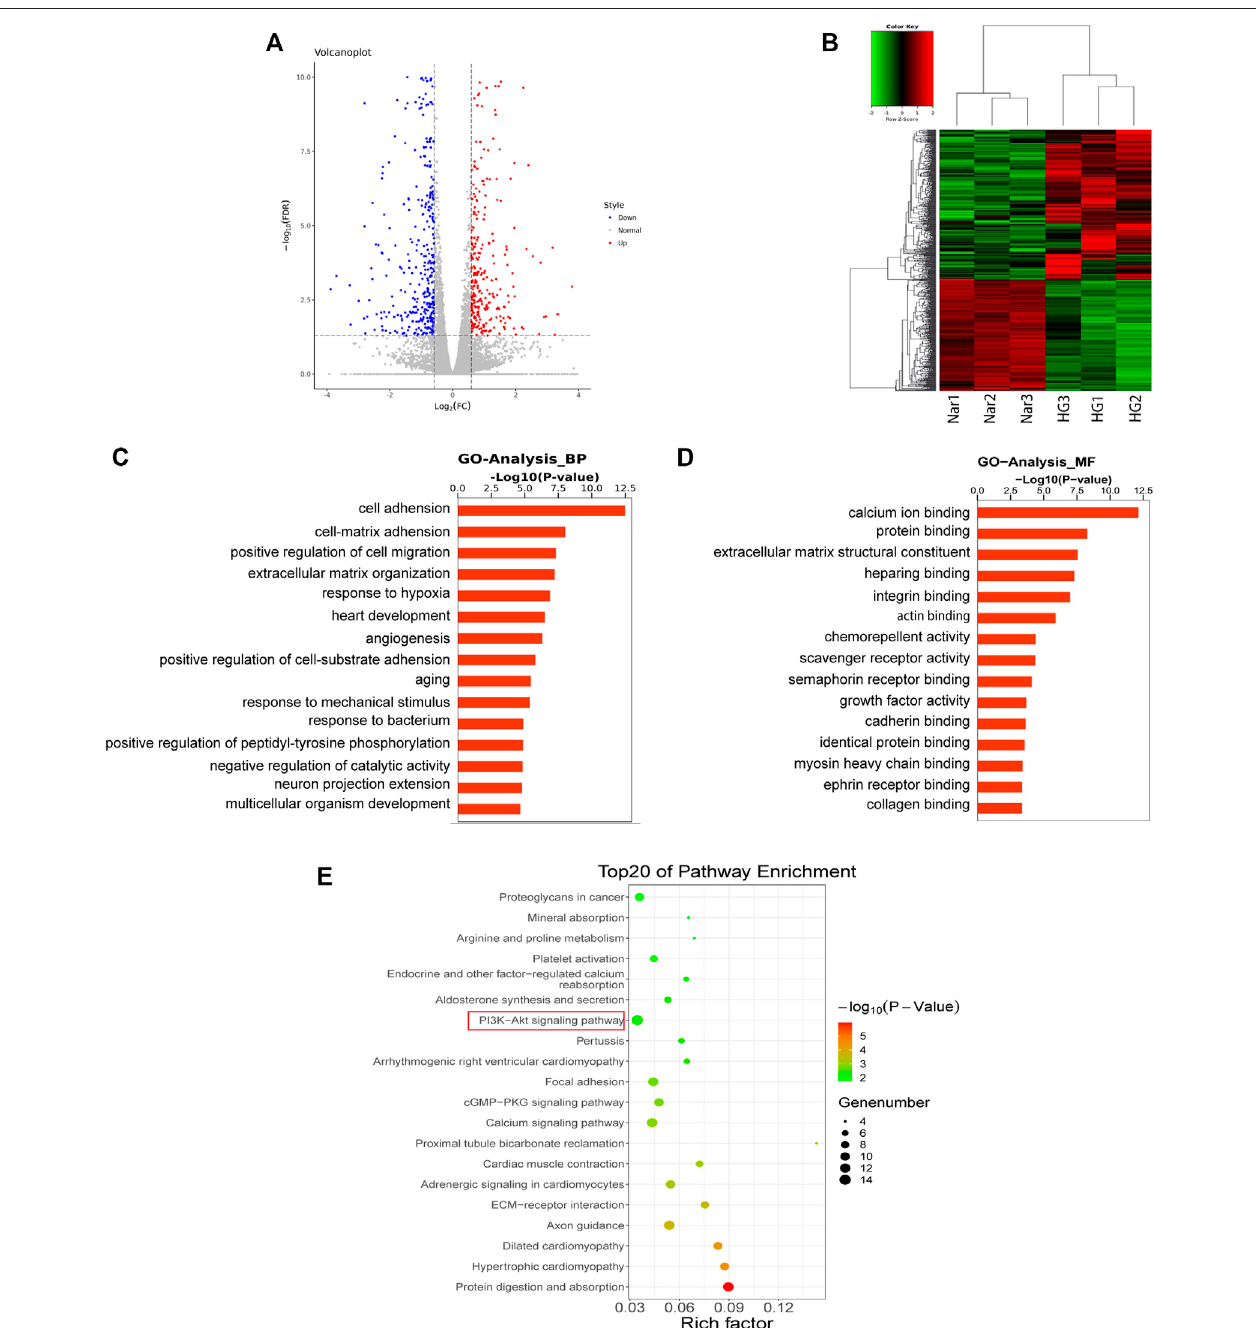
FIGURE7| Resultsoftranscriptomicsequencinganddataanalysis (A) AvolcanoplotindicatesthemRNAexpressionpro fi leoftheNargroupvstheHGgroup. (B) Heatmap shows the clustering of mRNAs between the Nar and HG groups of VSMCs. Up- and downregulated genes are colored in red and blue, respectively. (C) GO enrichment (BP) analysis of transcriptomic analysis. (D) GO enrichment (MF) analysis of transcriptomic analysis. (E) Top 20 most enriched KEGG categories for the downregulated genes shows the vital Nar-related signaling pathway against diabetic angiopathies according to transcriptomic analysis.